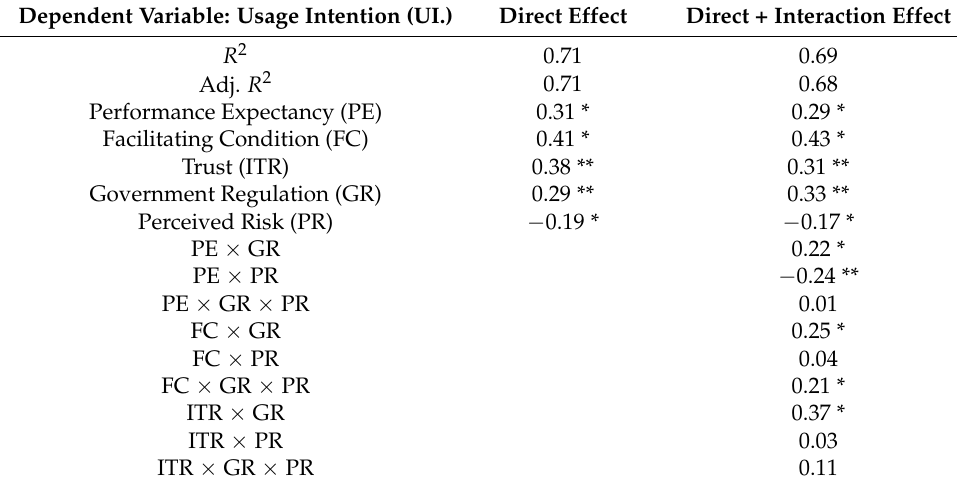
Table 5. Path coefficients (including moderation and interaction